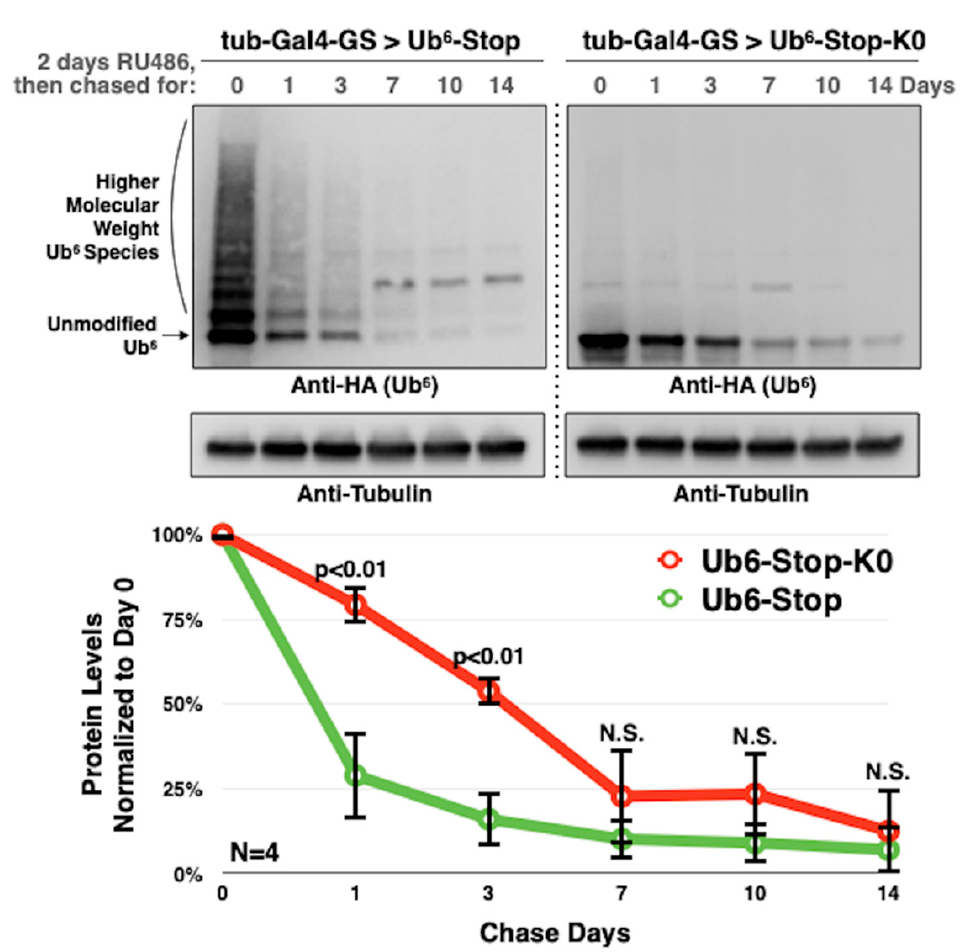
Figure 3. Decelerated turnover of lysine-less, non-cleavable ubiquitin chains in flies. Western blots from flies expressing the noted Ub 6 transgenes under the RU486-dependent driver, tub-Gal4-GS for 2 days, and then "chased" in the absence of the inducer for up to 14 days. Whole-fly lysates. Graphs in the bottom are quantifications from images on the top and other independent repeats. The entire signal for each lane was quantified. Shown are means ± standard deviation. ‘ p ’ values are from Student’s t -tests comparing Ub 6 -Stop-K0 to Ub 6 -Stop of the same timepoint. "N.S." denotes no statistical significance.